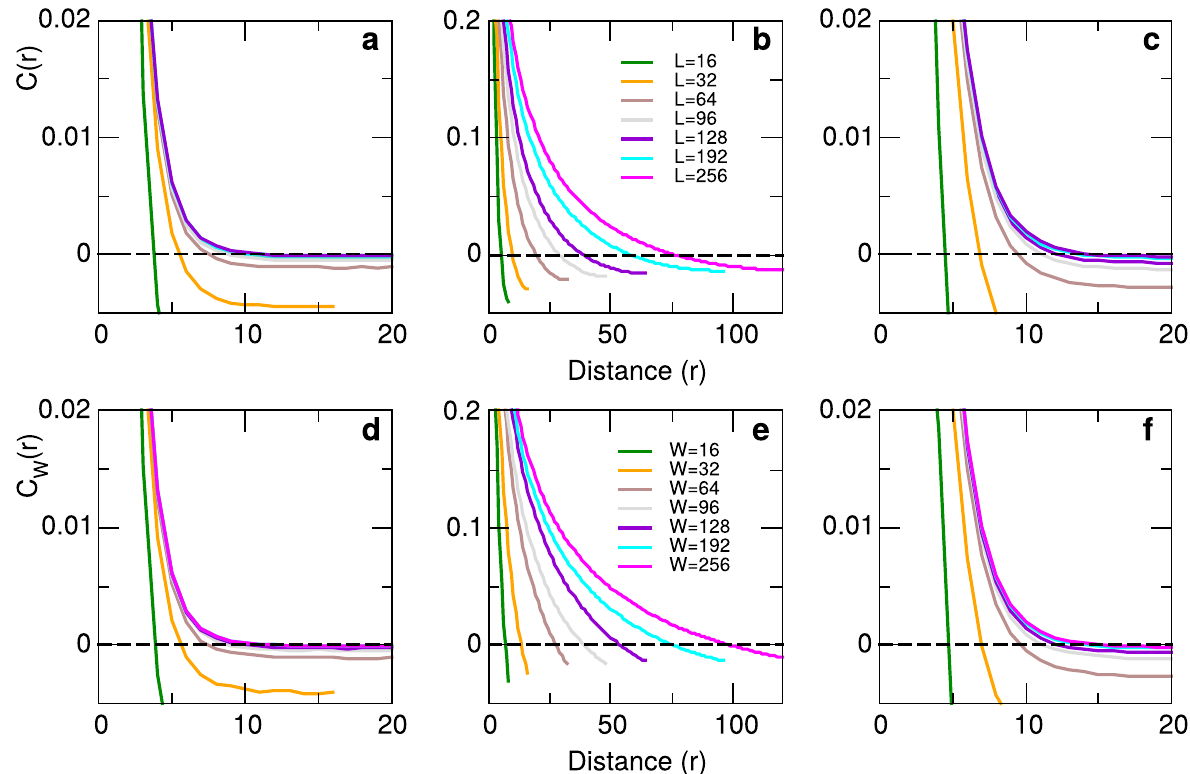
Figure 3. Connected correlation function for the ferromagnetic 2D Ising model. Typical results for three temperatures T = 2.00 (panels a , d ); T = 2.27 (panels b , e ) and T = 3.0 (panels c , f ) and various lattice and window sizes. Curves in the top panels computed from different system sizes L and those in the bottom panels computed on a system of size L = 600 using the window sizes W indicated in the